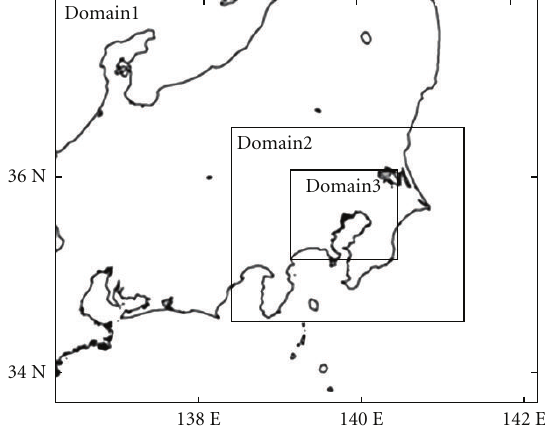
Table 2: Analysis domain sizes and grid